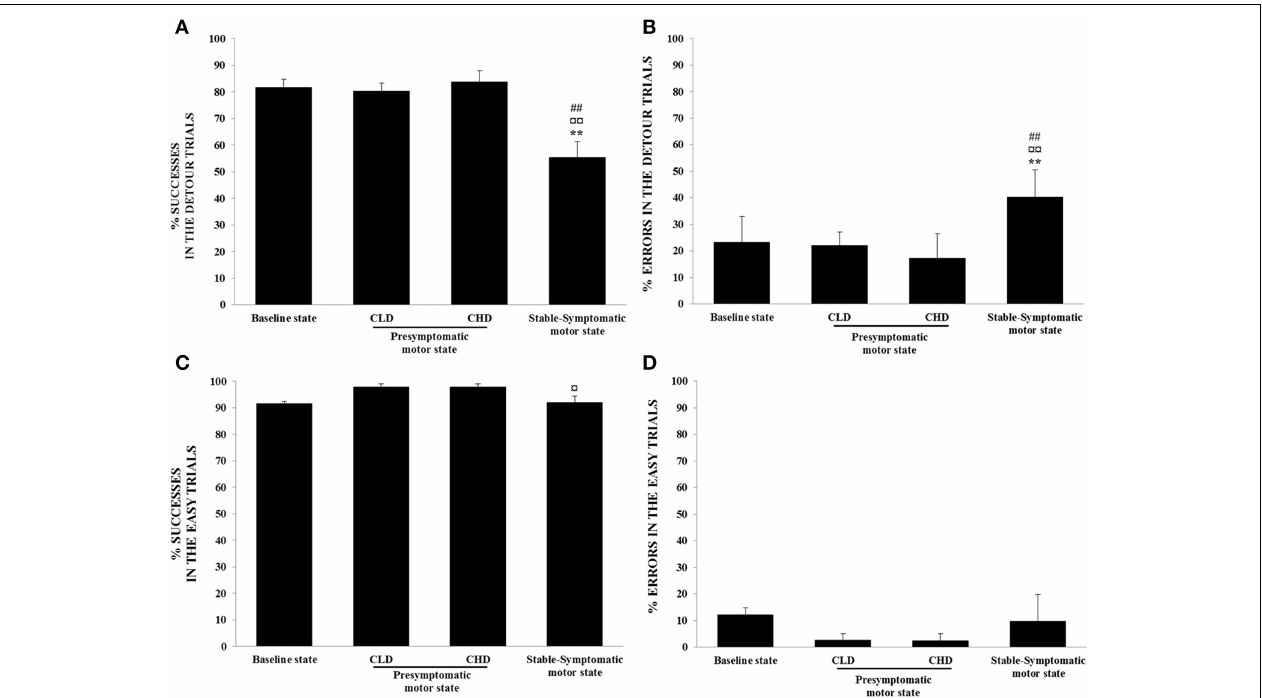
FIGURE 6 | Evolution of ORDT performance from baseline to presymptomatic and symptomatic motor states ( n = 4). (A) Successes in the detour trials: successes (retrieval of reward on the first reach) were expressed as percentage of total number of detour trials. Values were means ± SD ( n = 4). ∗∗ p < 0 . 01: stable-symptomatic motor state vs. baseline state; ¤¤ p < 0 . 01: stable-symptomatic motor state vs. CLD-presymptomatic motor state; ## p < 0 . 01: stable-symptomatic motor state vs. CHD-presymptomatic motor state (ANOVA and post-hoc test). (B) Errors in the detour trials: errors (barrier hits, i.e., hitting a transparent side of the box) were expressed as a percentage of responses observed for detour trials. Values were means ±